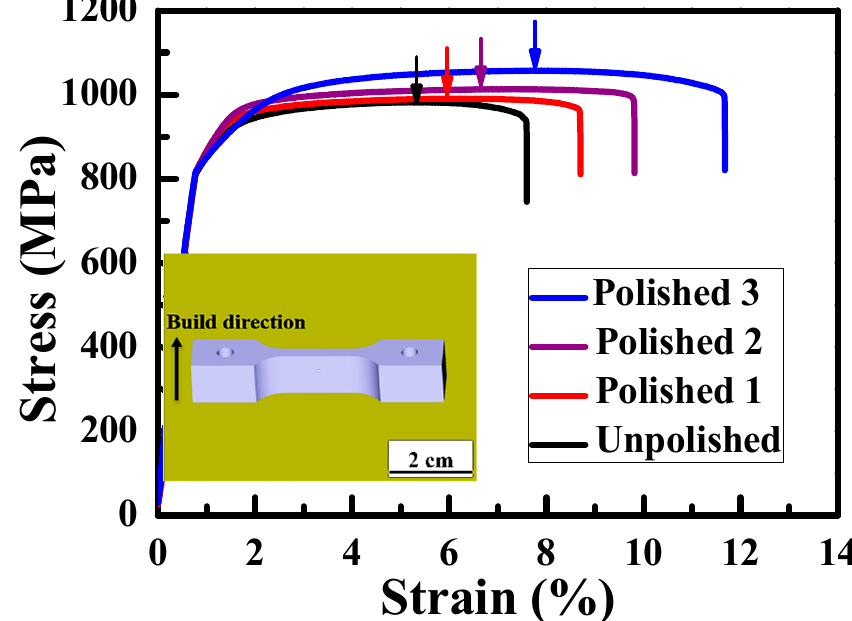
Figure 8. Tensile stress-strain curves of the unpolished (Ra ~ 24 µm), polished 1 (Ra ~ 15 µm), polished 2 (Ra ~ 10 µm), and polished 3 (Ra ~ 4.5 µm) samples. The necking positions were marked by